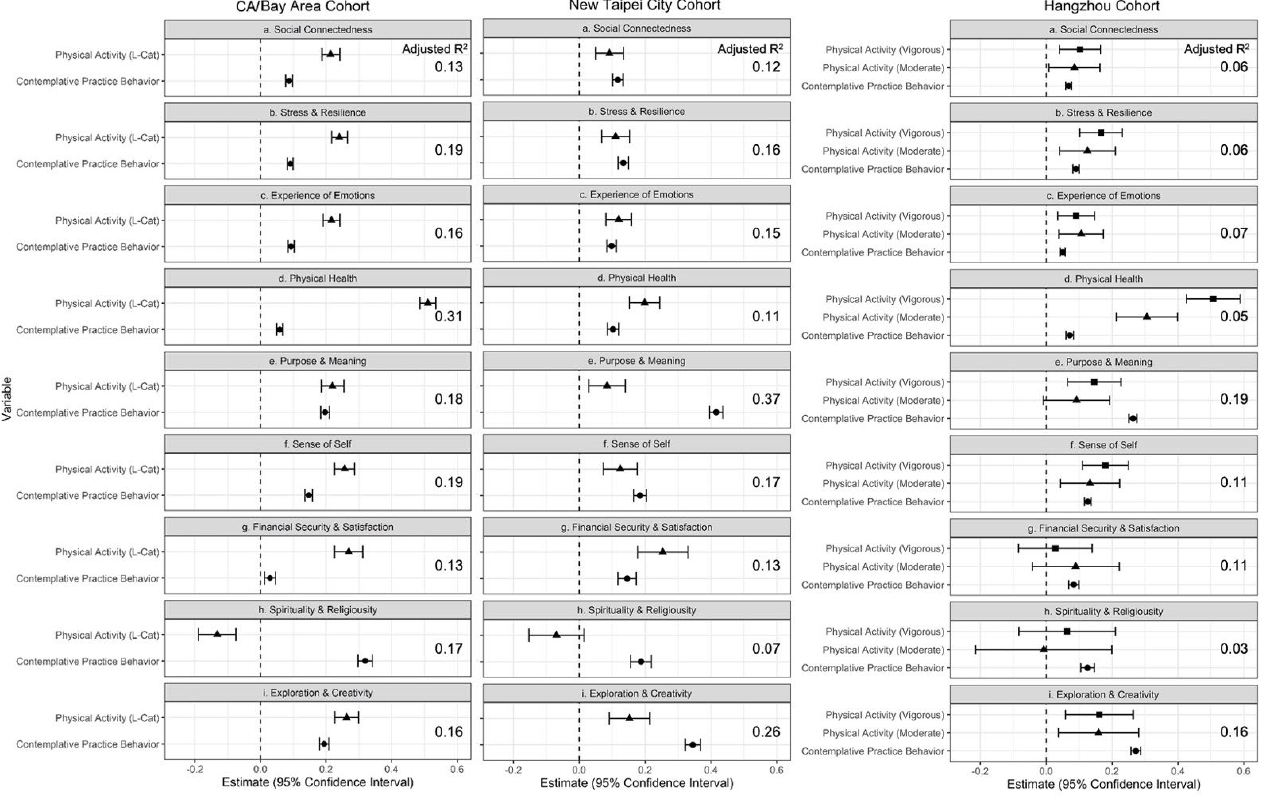
Figure 2. Associations between Contemplative Practice Behavior, Physical Activity, and Well-Being Domains. Note: A different physical activity measure was used for the Hangzhou cohort (Interna- tional Physical Activity Questionnaire; categorical variable with PA-Low as reference group) than for the CA/Bay Area and New Taipei City cohorts (L-Cat 2.2; ordinal variable, 1–6).